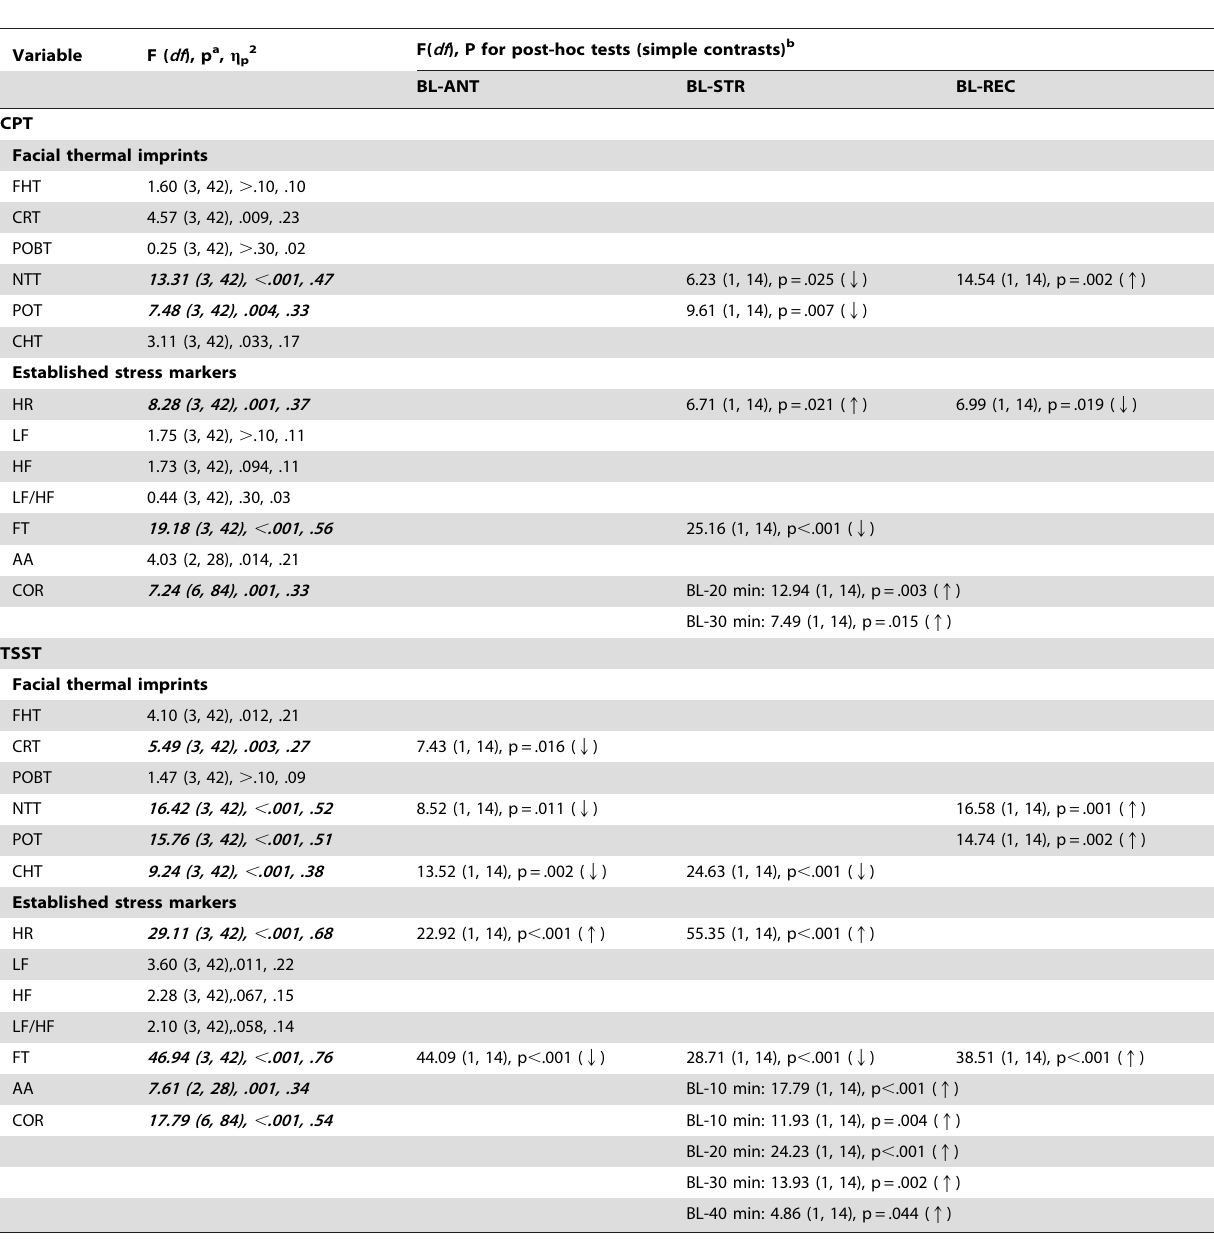
Table 2. Univariate statistics (one-way repeated measures ANOVAS with simple contrasts) for raw (logged for alpha-amylase and cortisol) scores over time in CPT and TSST.